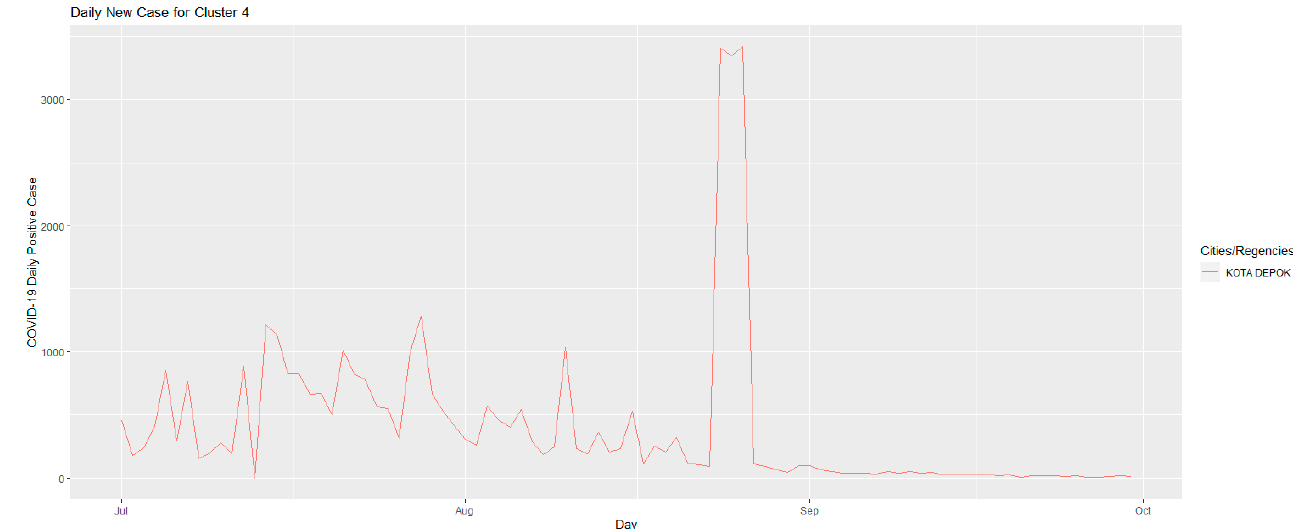
Figure 7. Daily positive cases of COVID-19 in Cluster 4 for the first period.